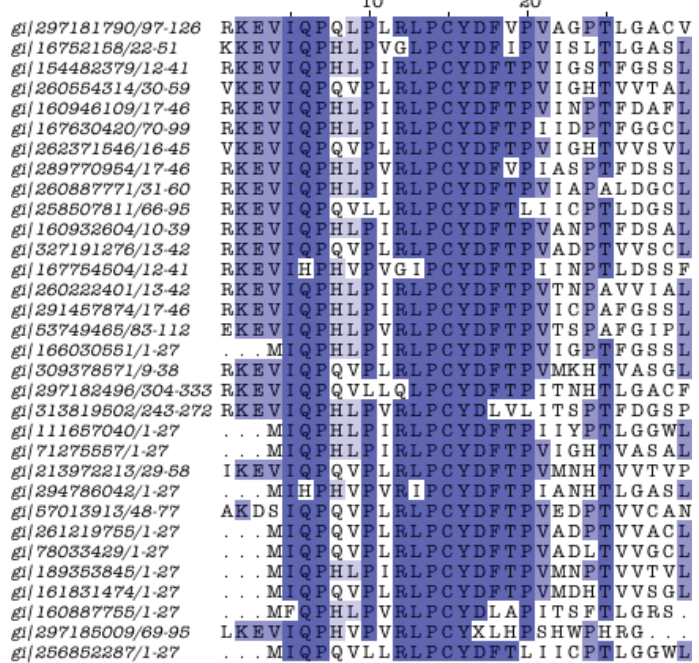
Figure 4. Alignment of the PCY domain. The PCY motif is centered around position 15 of the multiple alignment. The domain was discovered following five iterations with PSI-BLAST with CP0988 as query sequence (GI:16752158), until convergence and an e-value threshold 0.005. In total 70 sequences were recovered; redundancy was removed at 95% with Jalview [34], resulting in 32 sequences shown here. The length of the domain is just 30 residues; boxes signify sequence identity at 50% or above (darker color: more conserved). GI labels are provided, along with sequence coordinates on the left of the alignment (see text for more details and discussion).